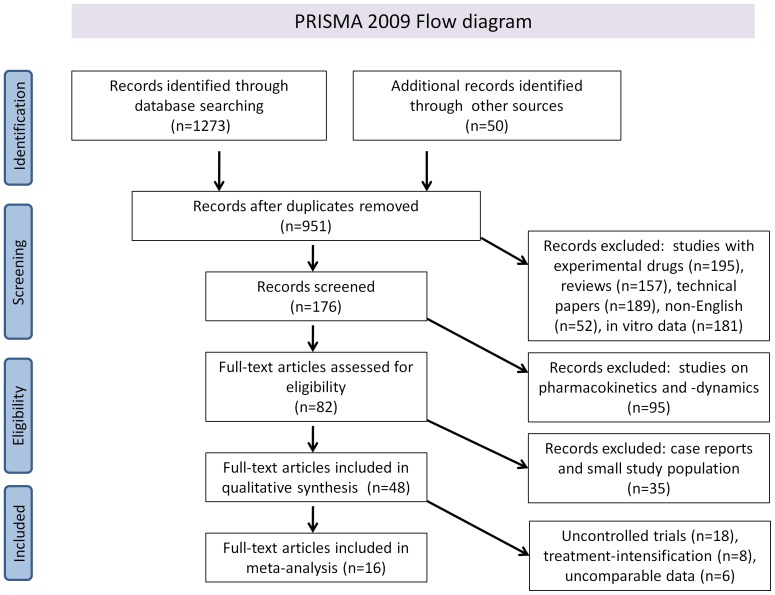
Prisma 2009 Flow diagram literature search and study selection.PRISMA diagram showing the different steps of systematic review, starting from literature search to study selection and exclusion. At each step, the reasons for exclusion are indicated.